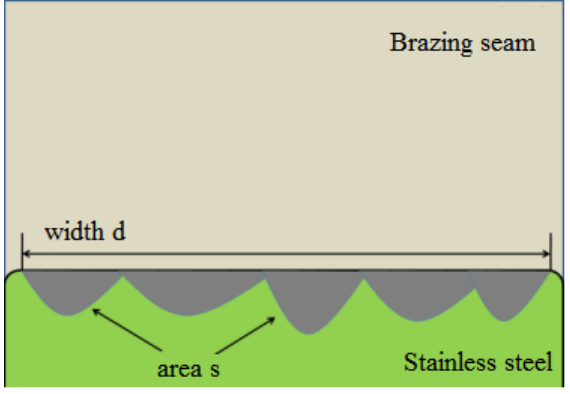
Figure 5. Diagram of intergranular penetration depth calculation.